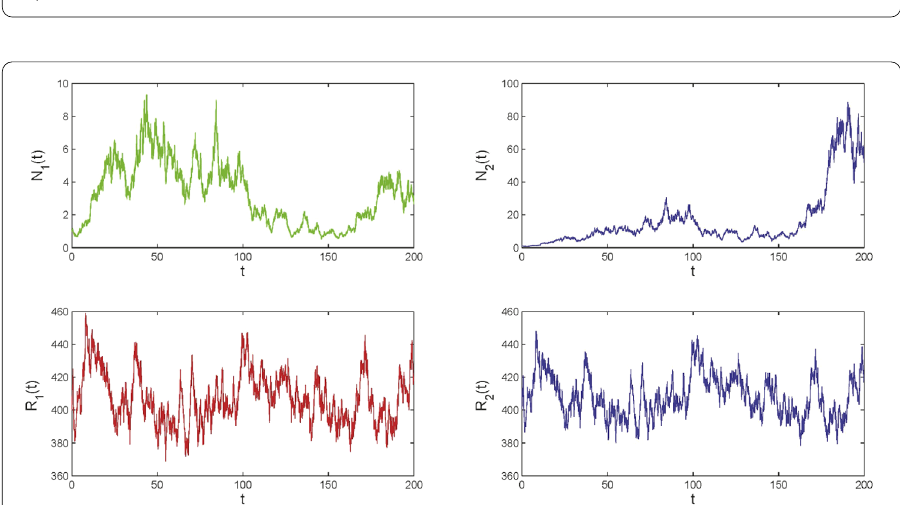
Figure 3 Time evolution of the system in Example 1 with initial condition (1,400) when m 2 = 0.325, m 1 = 0.315